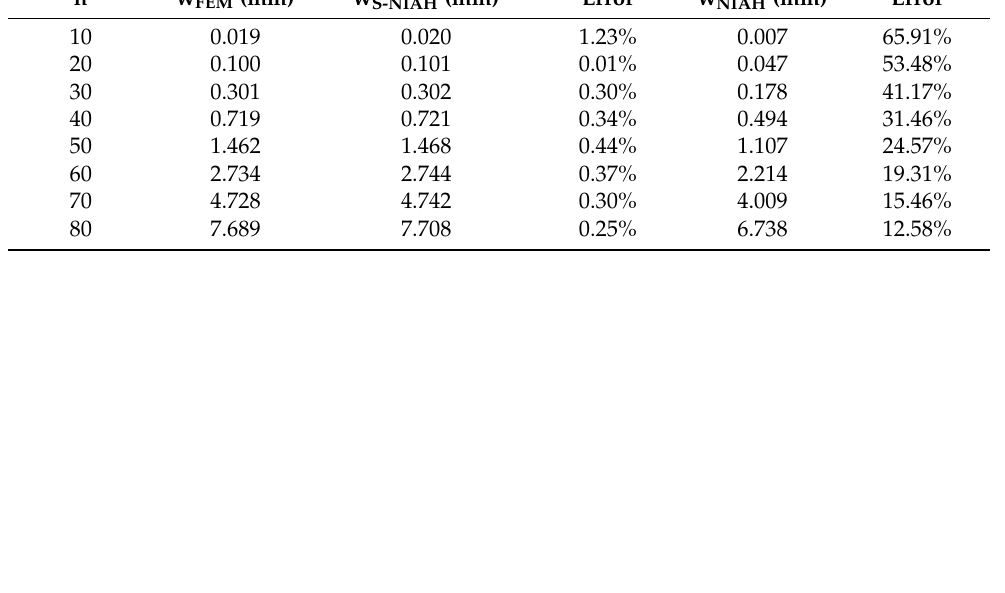
Figure 12. Relative error with respect to n under different methods.